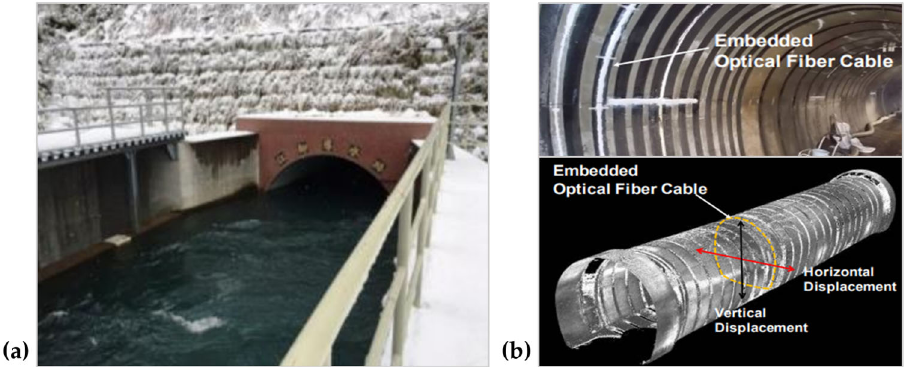
Figure 13. Real-time strain monitoring of the aqueduct tunnel using DOFS. ( a ) The end of the subject aqueduct tunnel. ( b ) Embedded optical fiber cable in the retrofitted tunnel. Reprinted with permission from [185].